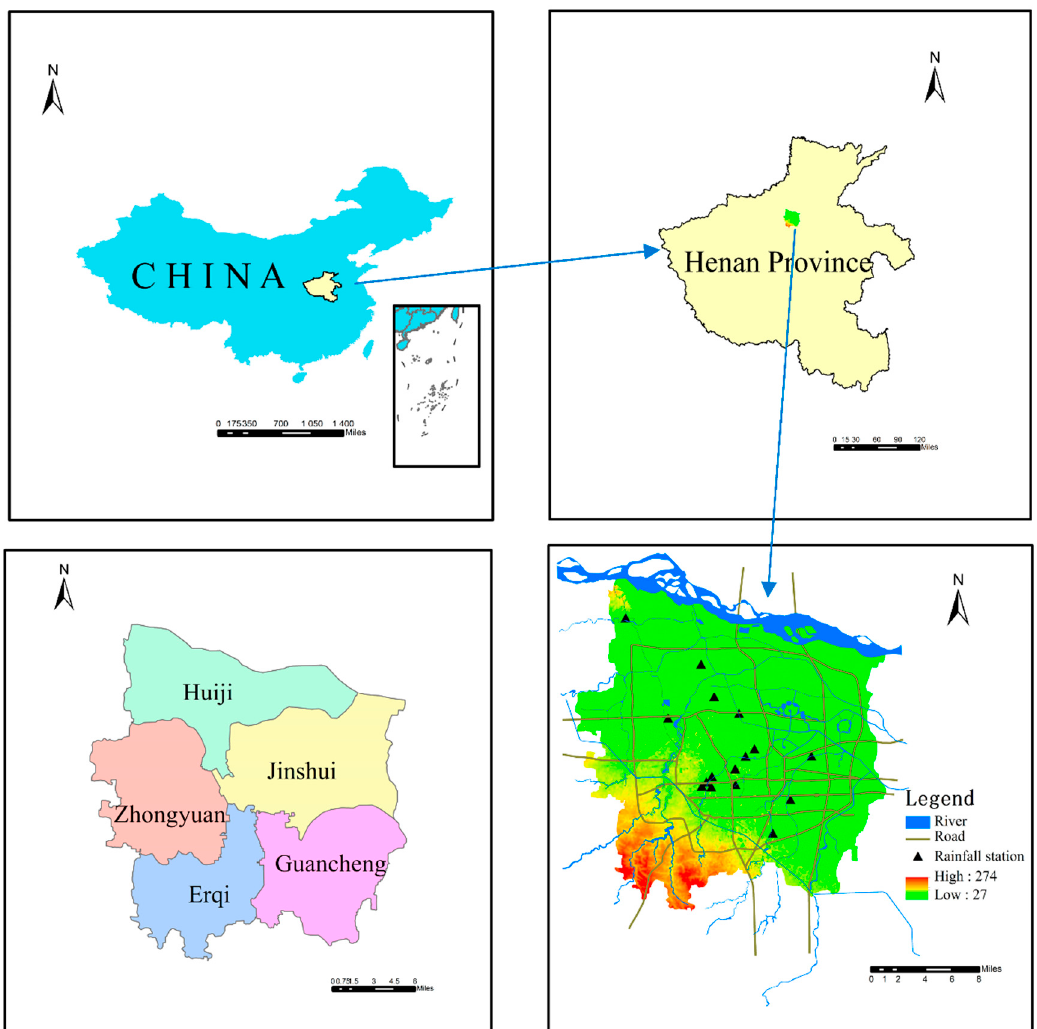
Figure 1. Location and partition of the study.